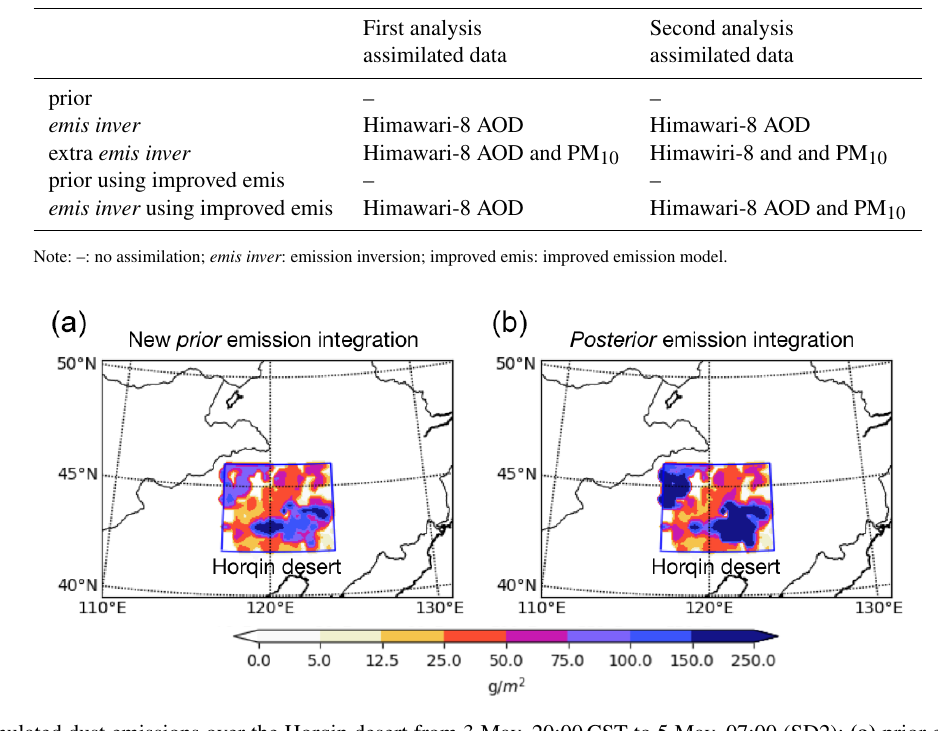
Figure 9. Accumulated dust emissions over the Horqin desert from 3 May, 20:00CST to 5 May, 07:00 (SD2): (a) prior emissions; (b) pos- terior emissions. The “old” priori and posterior accumulated emission map can be seen in Fig.